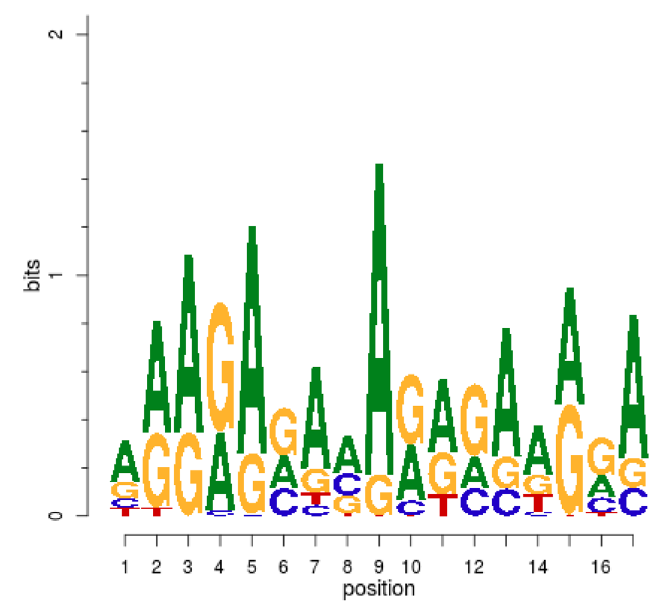
Figure 11. Motif logos found during de-novo motif